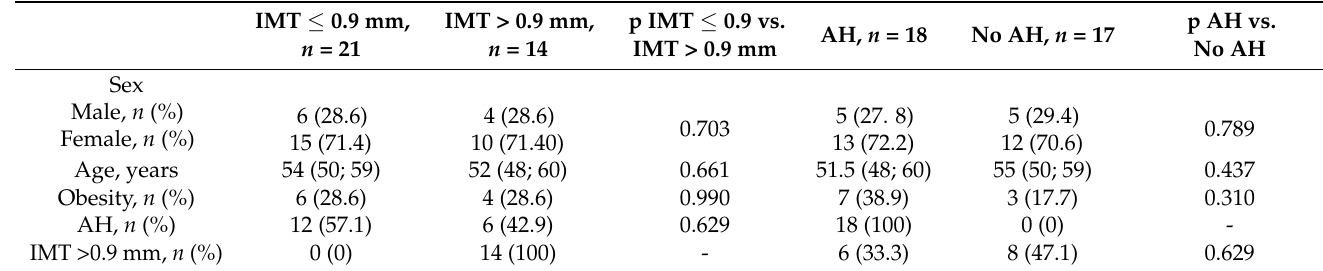
Table 1. Basic data of individuals included in the study.